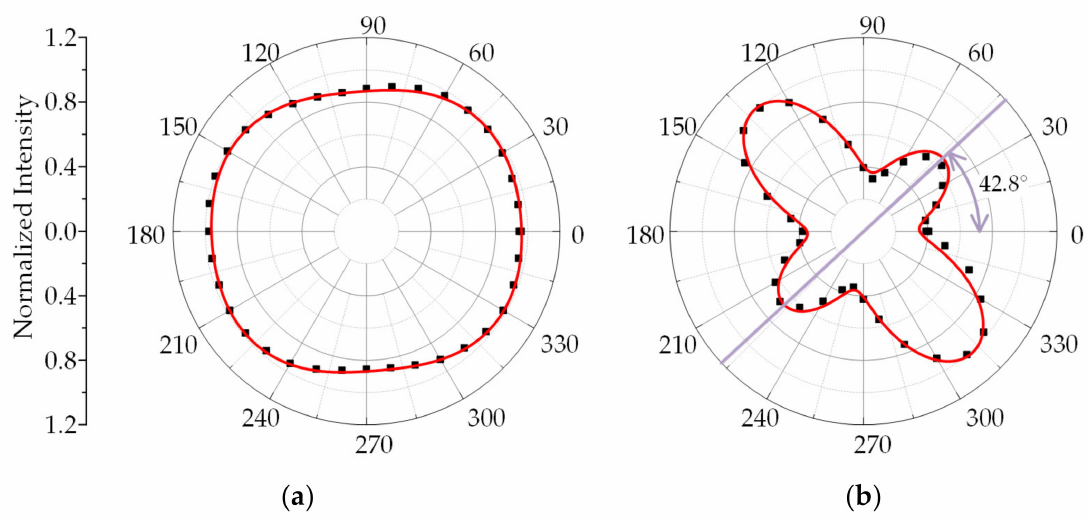
Figure 6. Comparison of the experimental results (black solid points) and theoretical results (red solid line) under the vertical backscattering configuration in the ( a ) HH case and in the ( b ) HV